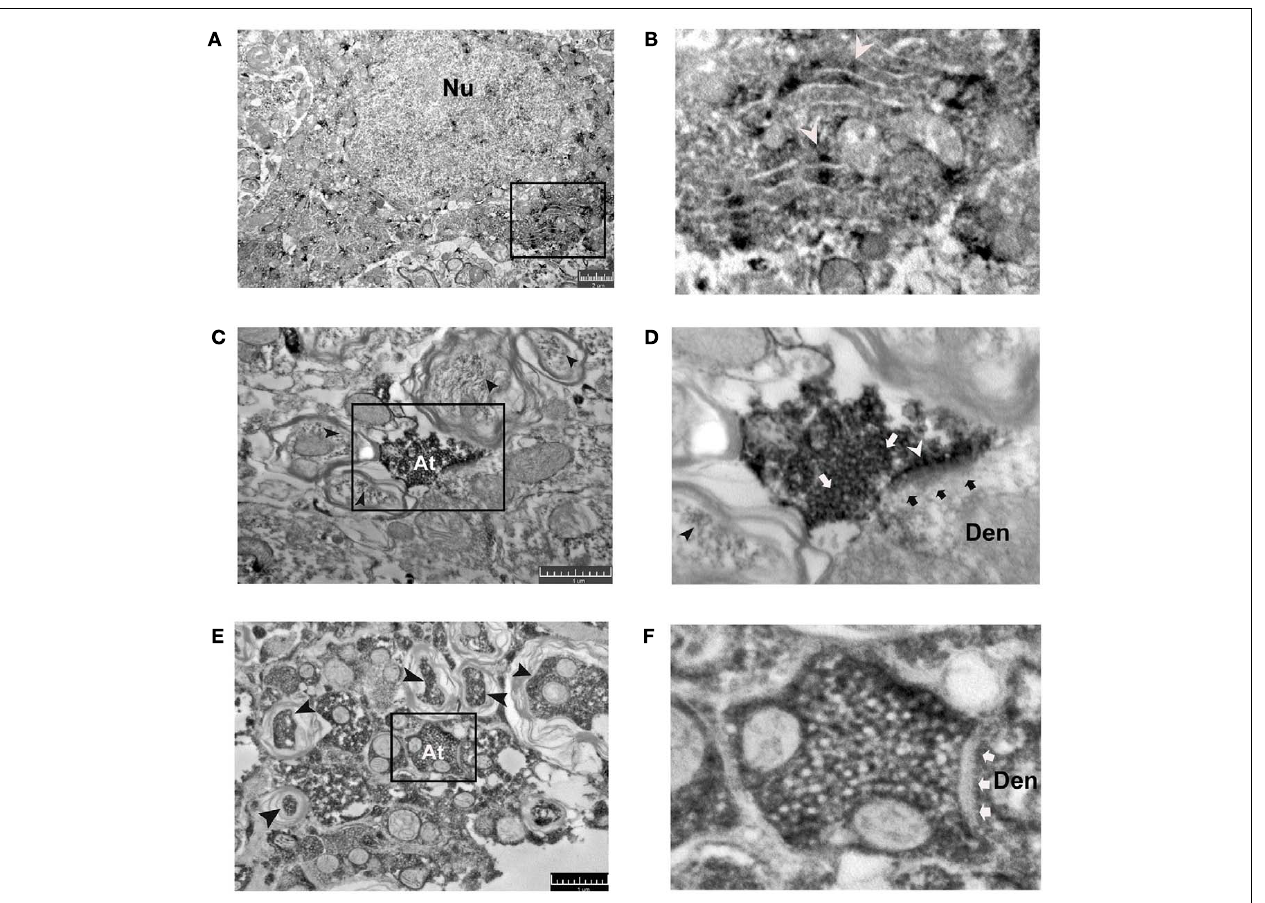
contact the unlabeled dendrites [Den, black arrows point to the post-synaptic density, white arrowhead indicates synaptic cleft filled with more intense, DAB reaction from released dynorphin (D) ]. (D) PRDN-IR rounded vesicles (white arrows) are seen. Light PRDN labeling of myelinated axons is also seen [black arrowheads (C,D) ]. (E,F) VGLUT2 labeling is seen in myelinated axons (black arrowheads), axon terminals (At), and dendrites (Den). (F) VGLUT2 labeled terminals contactVGLUT2 labeled dendrites (black arrows indicate the synaptic cleft).The scale bars measure 2 μ m in (A) and 1 μ m in (C,E) . Abbreviations are as in Figures 1 and 2